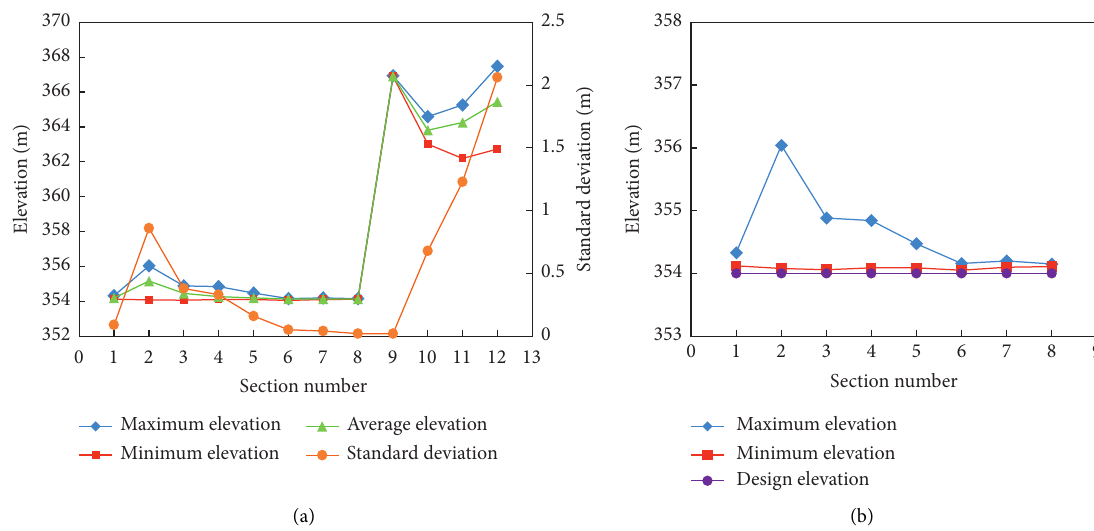
Figure 12: Comparison diagram of section elevation of the bottom outlet stilling basin. (a) Diagram of section elevation and standard deviation. (b) Section elevation change of stilling basin apron.